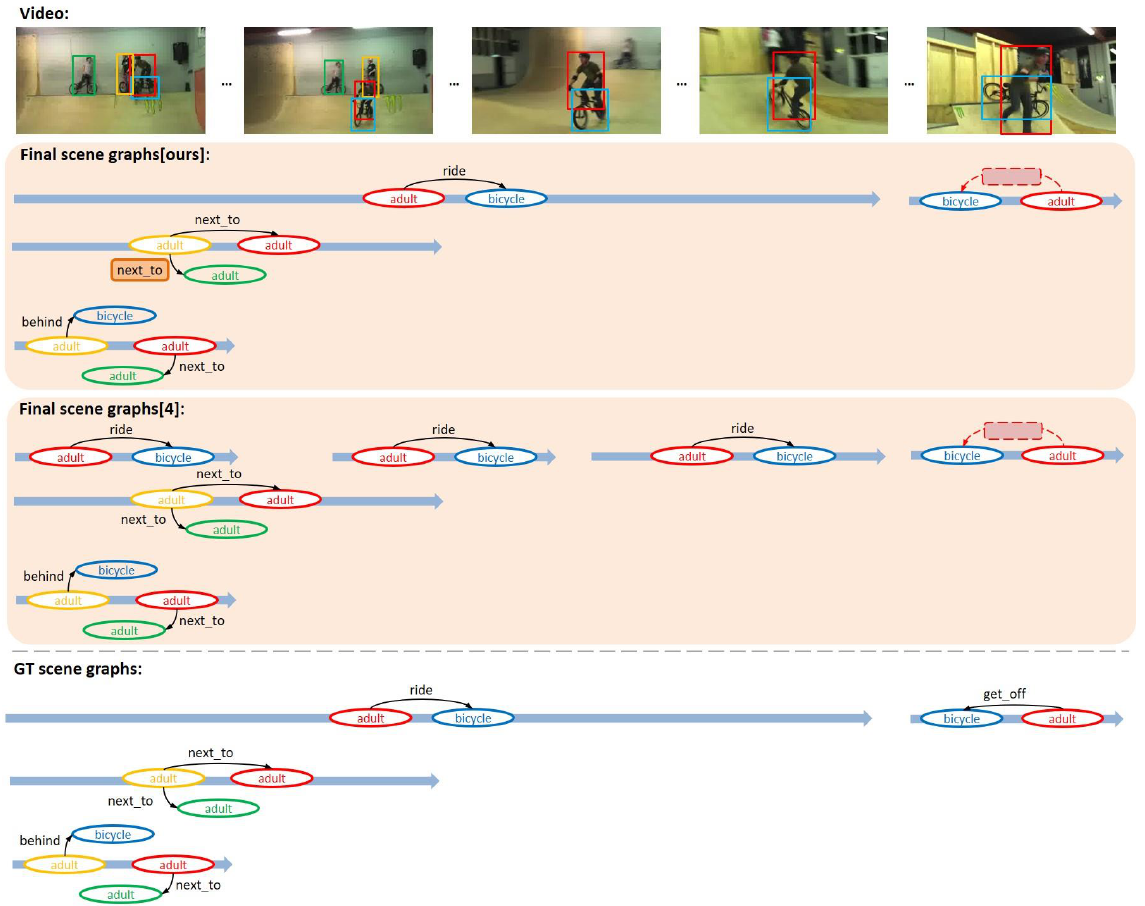
Figure 7. Second example of VidSGG task performed by the proposed